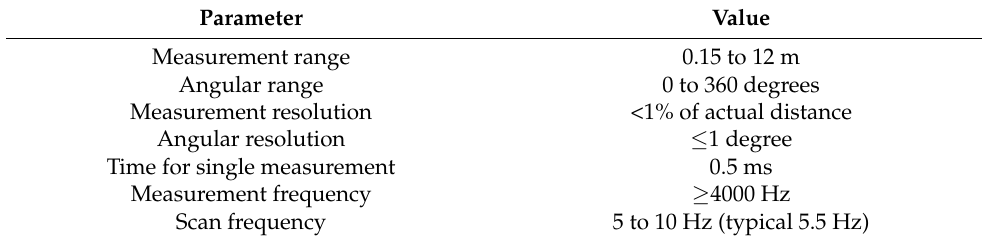
Table 1. RPLiDAR A1M8 performance specifications (based on information from [43]).